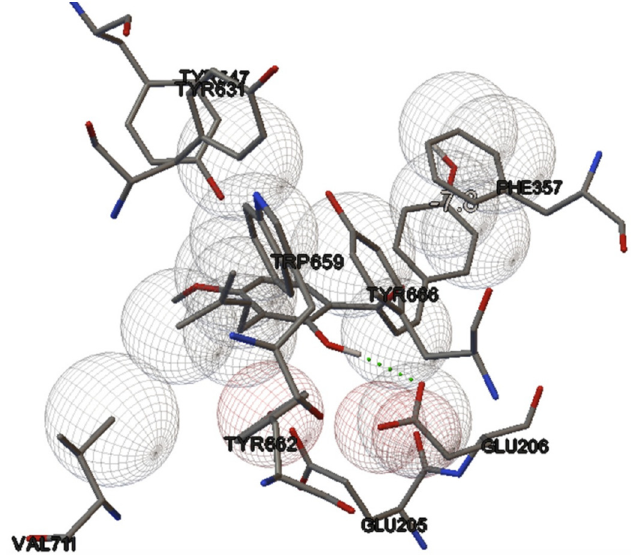
Figure 5. The binding mode of 4-HD with DPP-IV. 4-HD interacts with Glu 206 via HB (shown with green dotted-lines).